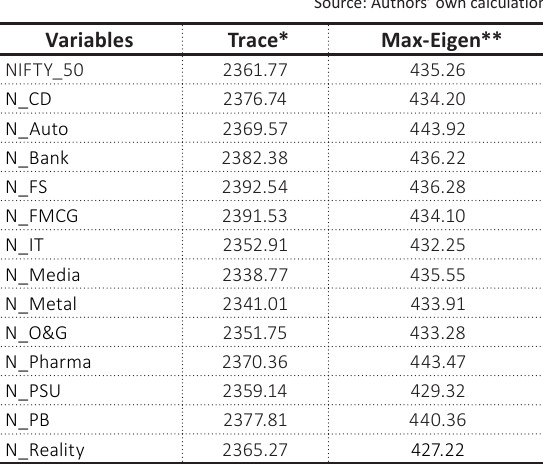
Table 3. Results of Johansen’s cointegration